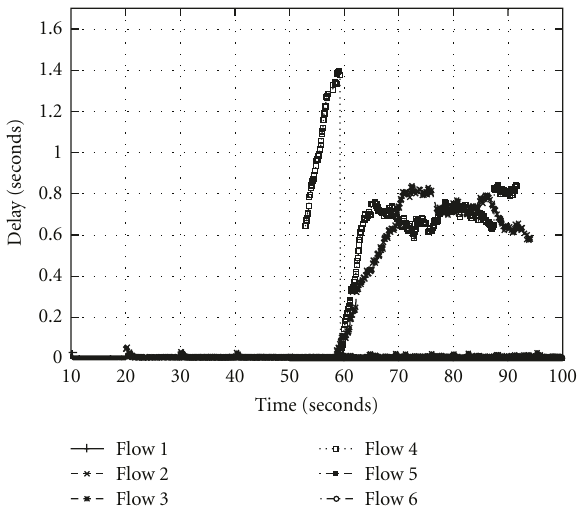
Figure 12: Delay of six flows versus time when no admission control algorithm is employed. RTS/CTS mechanism is